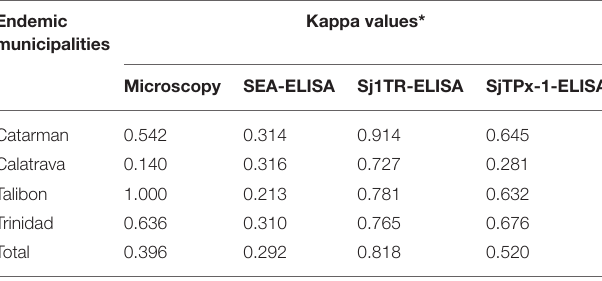
TABLE 3 | Statistical agreement of the diagnostic tests in selected schistosomiasis-endemic municipalities. Endemic